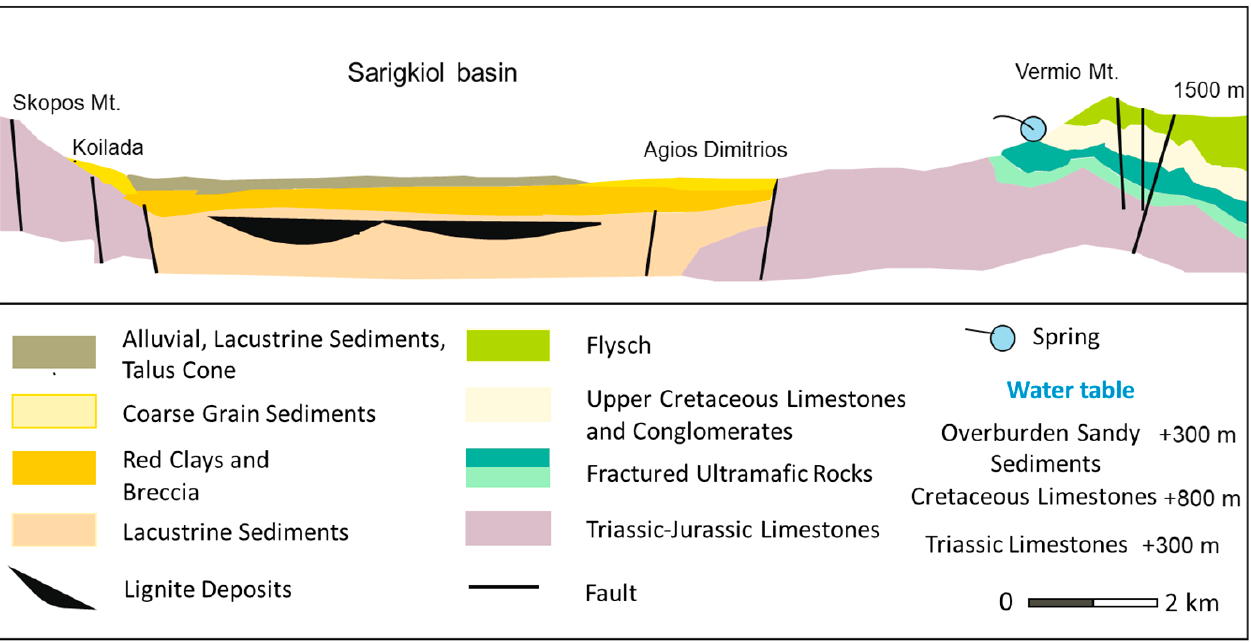
Figure 2. A simplified geological section of the western Vermio Mt.